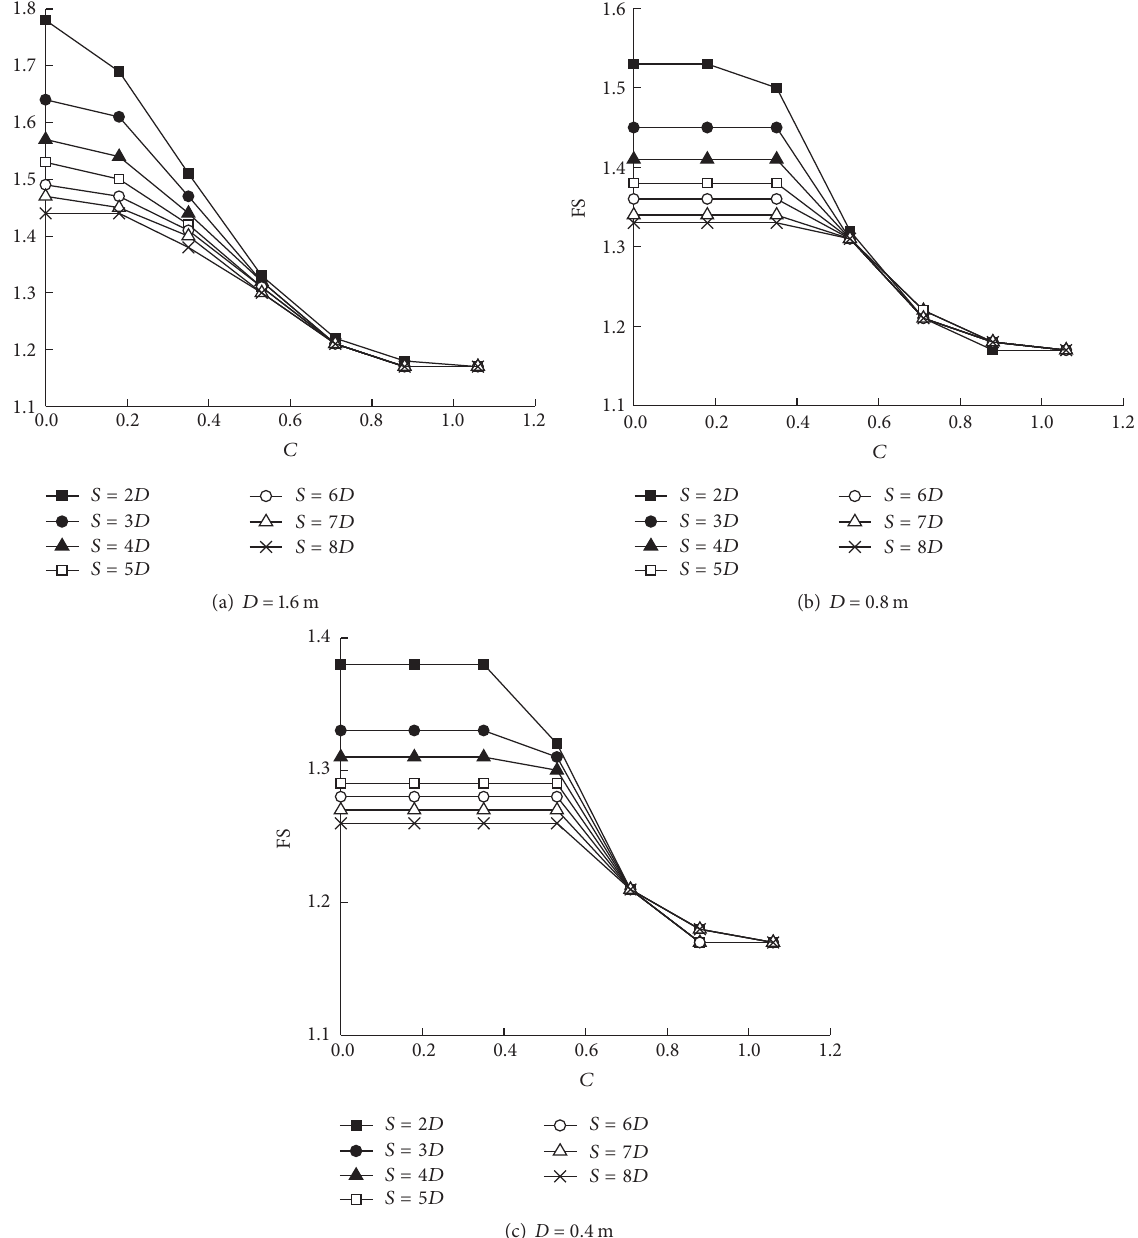
Figure 9: FS values of the piled slopes for Model A